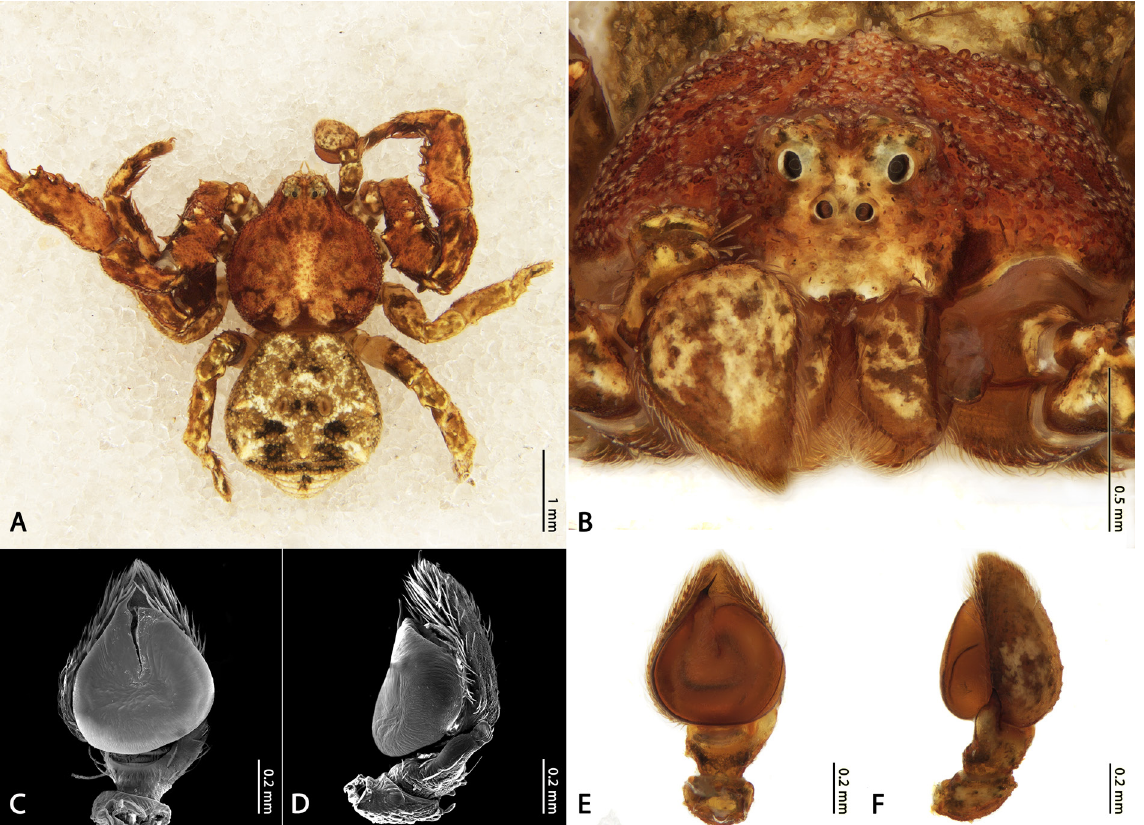
Fig. 13. Male of Kryptochroma quadrata Machado & Viecelli gen. et sp. nov., holotype (MPEG 22673). A . Habitus, dorsal view. B . Front. C–F . Left male palp. C, E . Ventral view. D, F . Retrolateral